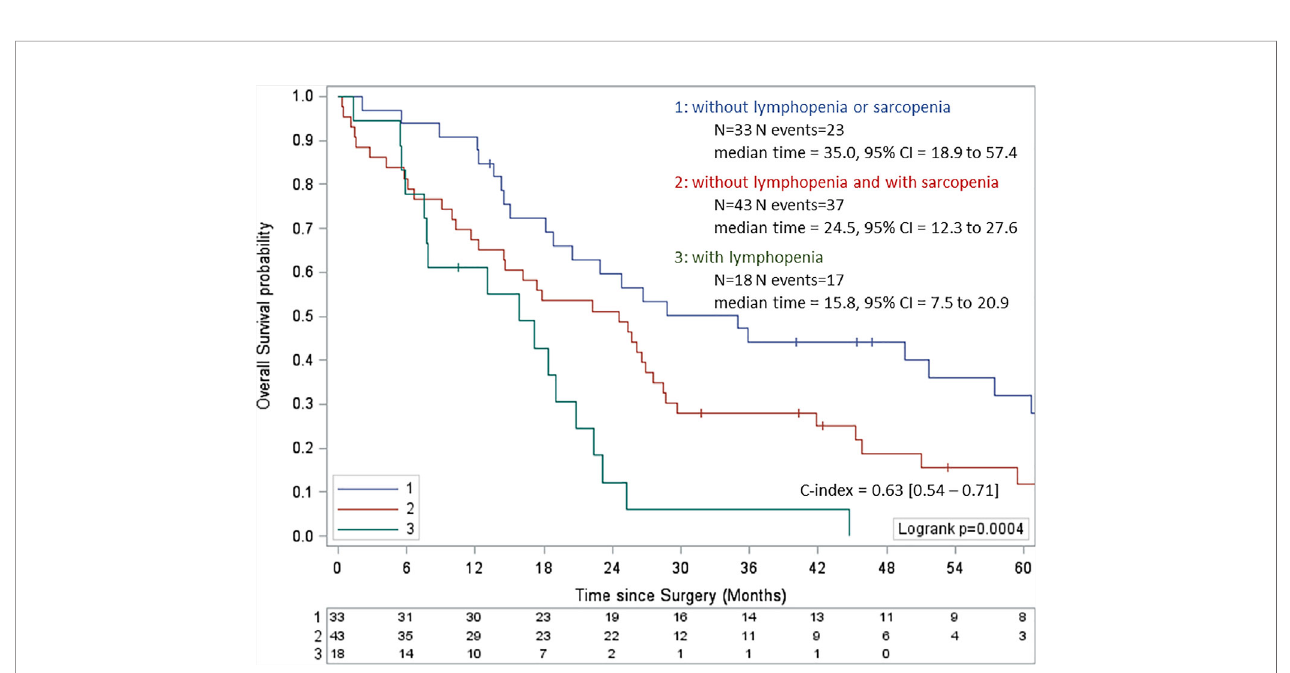
FIGURE 3 | Kaplan-Meier curves of overall survival according to preoperative lymphopenia and sarcopenia. Values of the log-rank test P <0.05 were considered statistically signi fi cant, and all tests were two-sided. CI, con fi dence